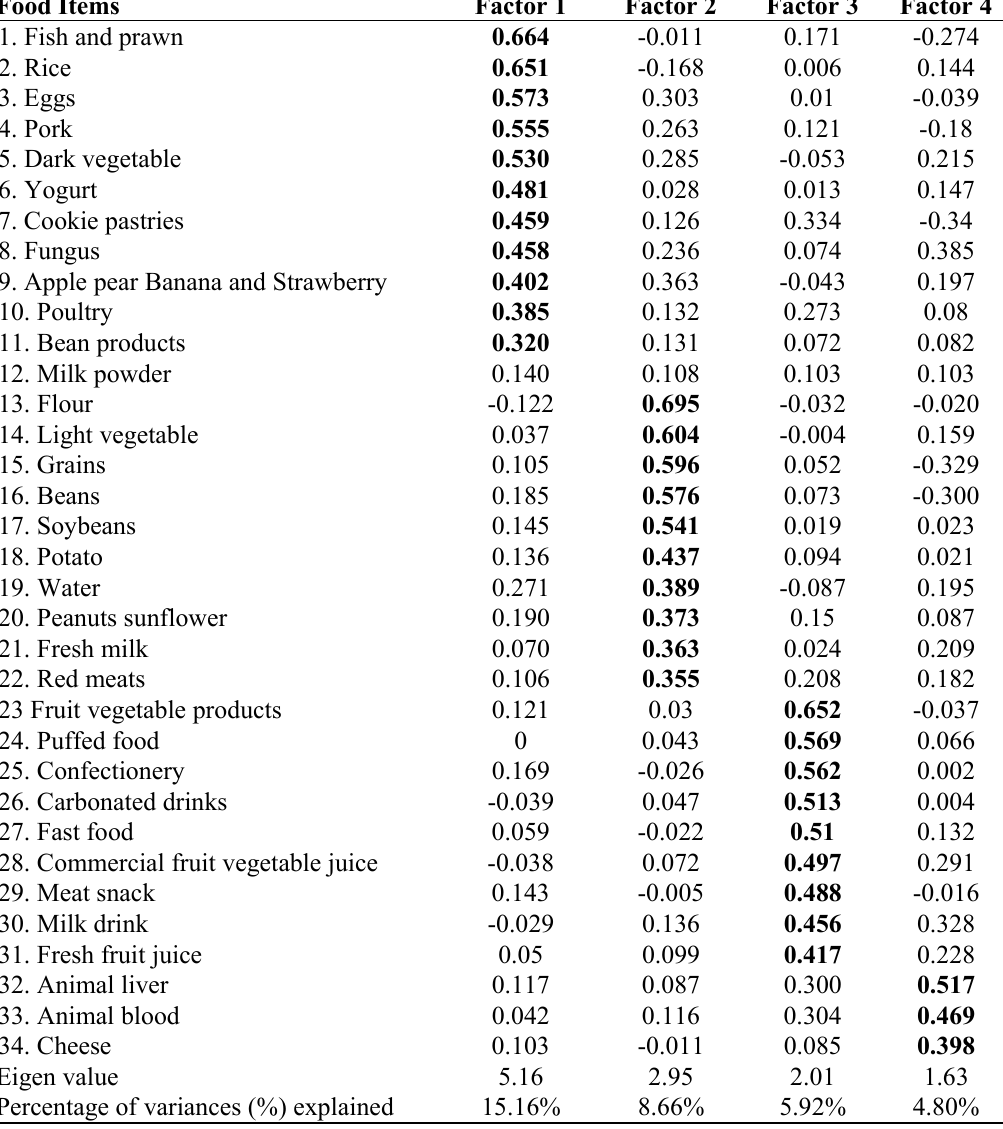
Table 1. Factor analysis